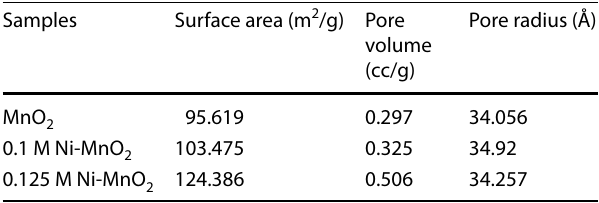
Table 3 BET specific surface area, pore-volume, and pore radius of MnO and Ni-MnO NPs 2 2 Samples